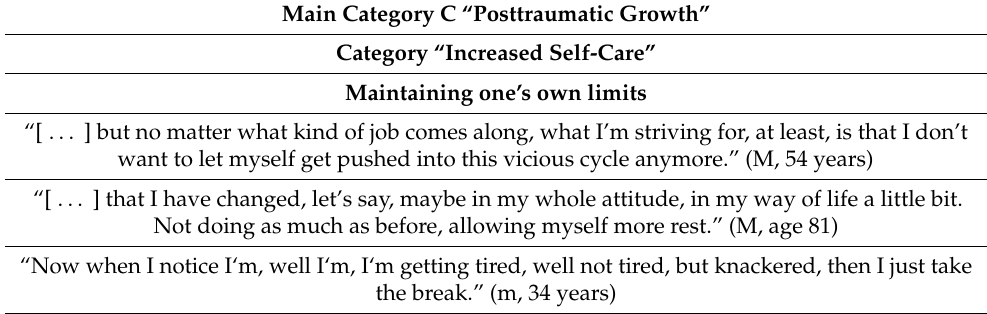
Table A3. Example quotes on the themes and categories within main category C “Posttraumatic